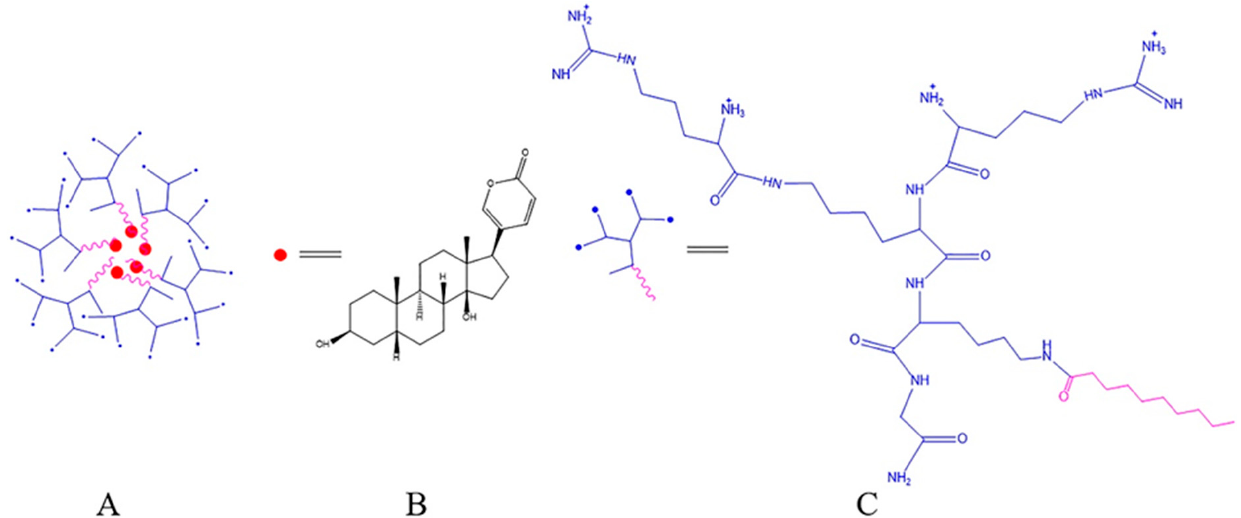
Figure 12. Molecular structure of bufalin-peptide-dendrimer inclusion ( A ); bufalin ( B ) and peptide- dendrimer ( C ).